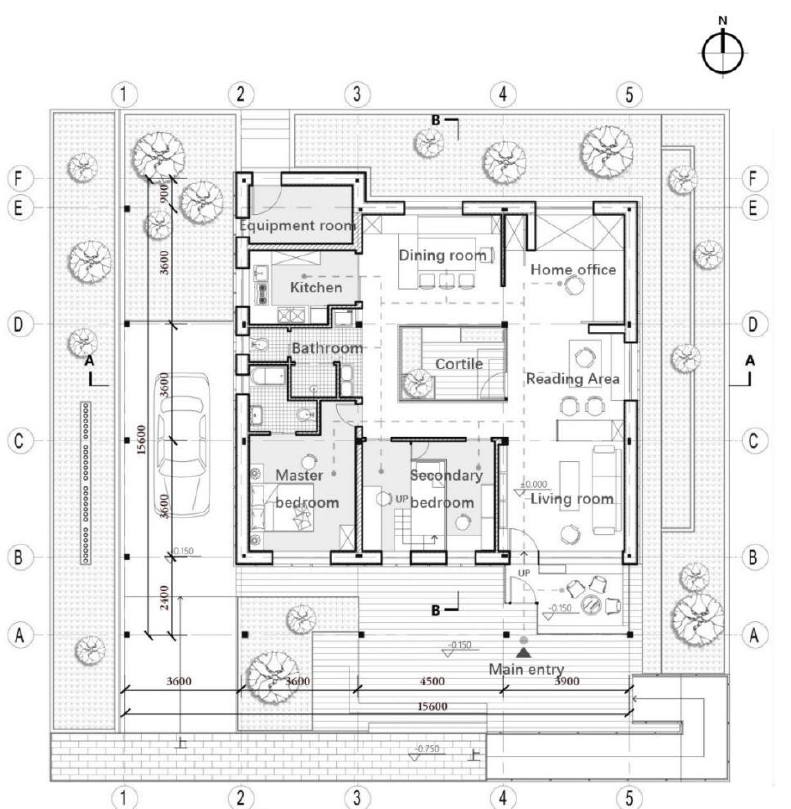
Figure 10. BIM-based floor plan of T&A House.